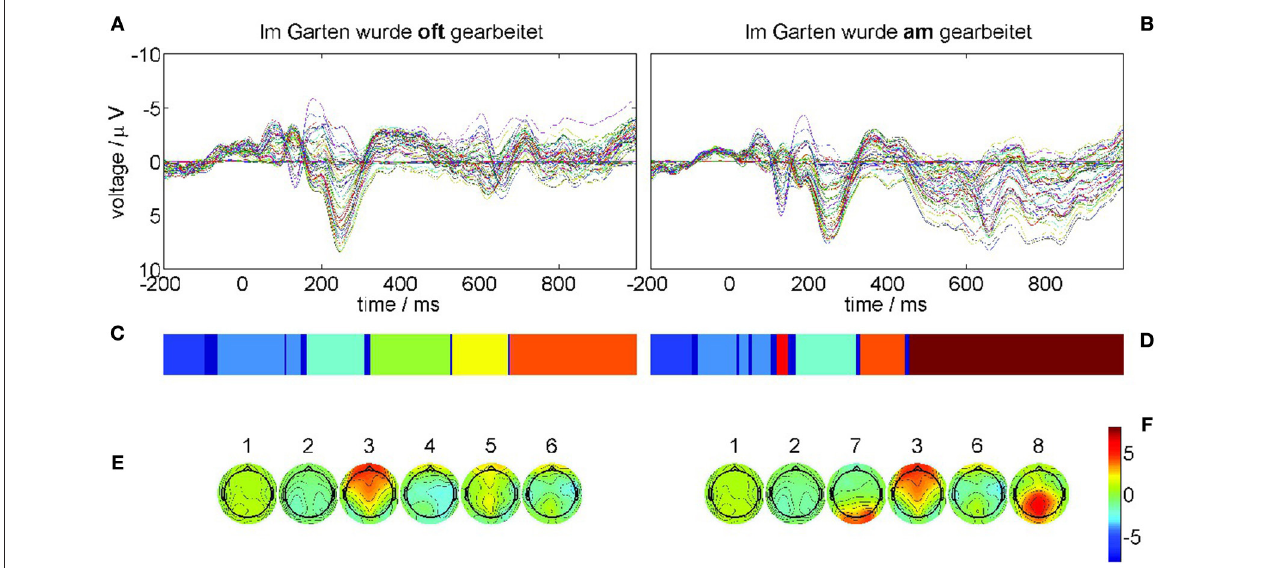
FIGURE 5 | ERP grand averages and optimal recurrence grammar partition for experimental data taken from [44]. The panels (A,C,E) show results for the correct condition (22-a), the panels (B,D,F) for the phrase structure violation condition (22-b). (A,B) grand average ERPs over 17 subjects for all EEG channels, e.g., blue = electrode C5, green = electrode T7, and red = electrode FC5 (according to the 10–20 system of EEG electrode placement); each trace shows the time series of measured voltages in one recording channel. (C,D) Optimal encodings p aligned through Hausdorff clustering, where each color denotes one symbol. (E,F) Centers of gravity as time-averaged scalp topographies. The numbers denote the segment numbers. The P600 ERP component corresponds to segment 8. It is important to note that the voltage axis is inverted according to the EEG